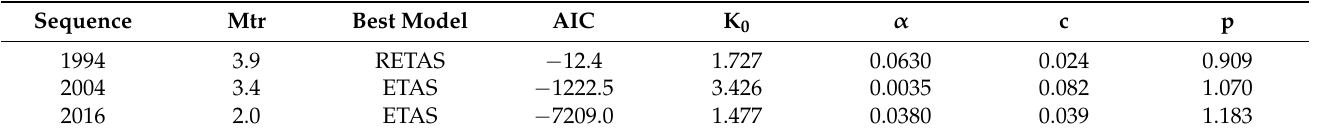
Figure 10. The AIC values of the RETAS model vs. the triggering magnitude for the three sequences. Table 3. The computed parameters for the RETAS